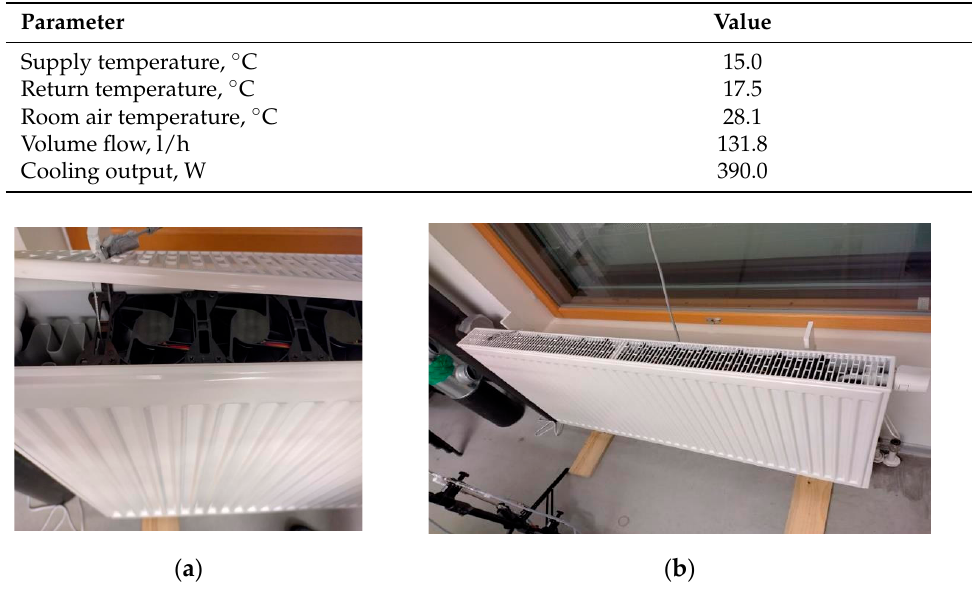
Figure 7 . Array of the fans with removed covering grill ( a ) and view of the radiator ( b ).